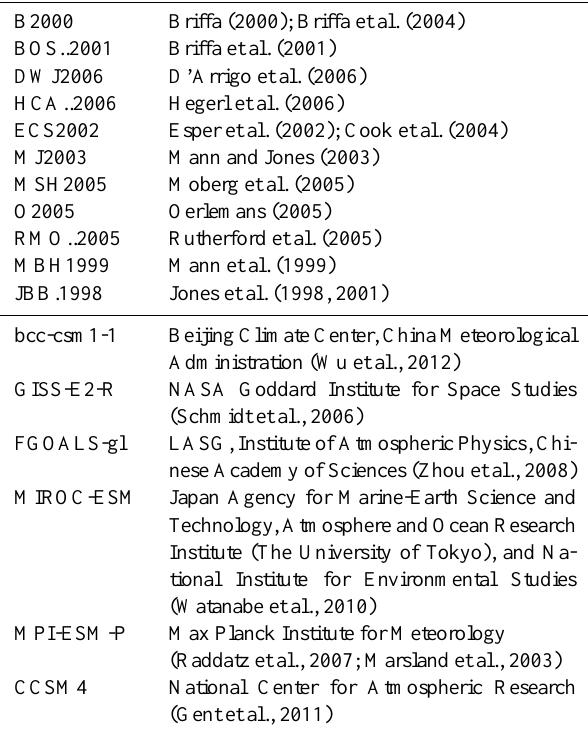
Table 1. Proxy series (top) and modelling groups (bottom) providing data used in Figs. 1 and